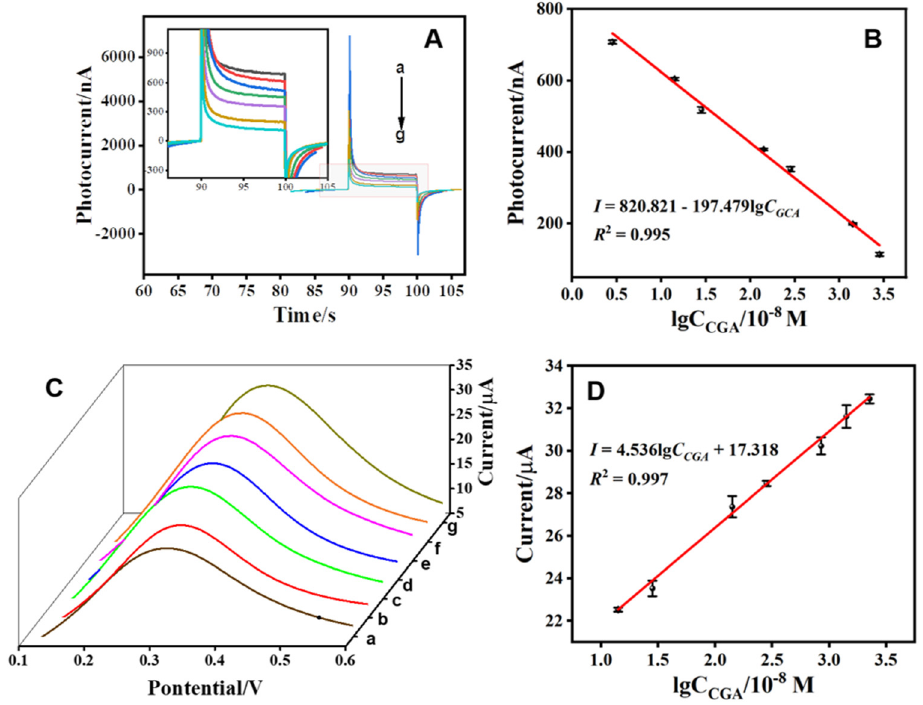
Figure 5. ( A ) Photocurrent response of different concentrations of CGA: (a) 2.825 × 10 − 8 mol L − 1 , (b) 1.412 × 10 − 7 mol L − 1 , (c) 2.825 × 10 − 7 mol L − 1 , (d) 1.412 × 10 − 6 mol L − 1 , (e) 2.825 × 10 − 6 mol L − 1 , (f) 1.412 × 10 − 5 mol L − 1 , (g) 2.825 × 10 − 5 mol L − 1 ; ( B ) Its corresponding calibration curve of biosensor platform; ( C ) DPV response of different concentration of CGA: (a) 1.412 × 10 − 7 mol L − 1 , (b) 2.825 × 10 − 7 mol L − 1 , (c) 1.412 × 10 − 6 mol L − 1 , (d) 2.825 × 10 − 6 mol L − 1 , (e) 8.475 × 10 − 6 mol L − 1 , (f) 1.412 × 10 − 5 mol L − 1 and (g) 2.259 × 10 − 5 mol L − 1 ; ( D ) The corresponding calibration curve. Table 1. Comparison of the different approaches for determining CGA.